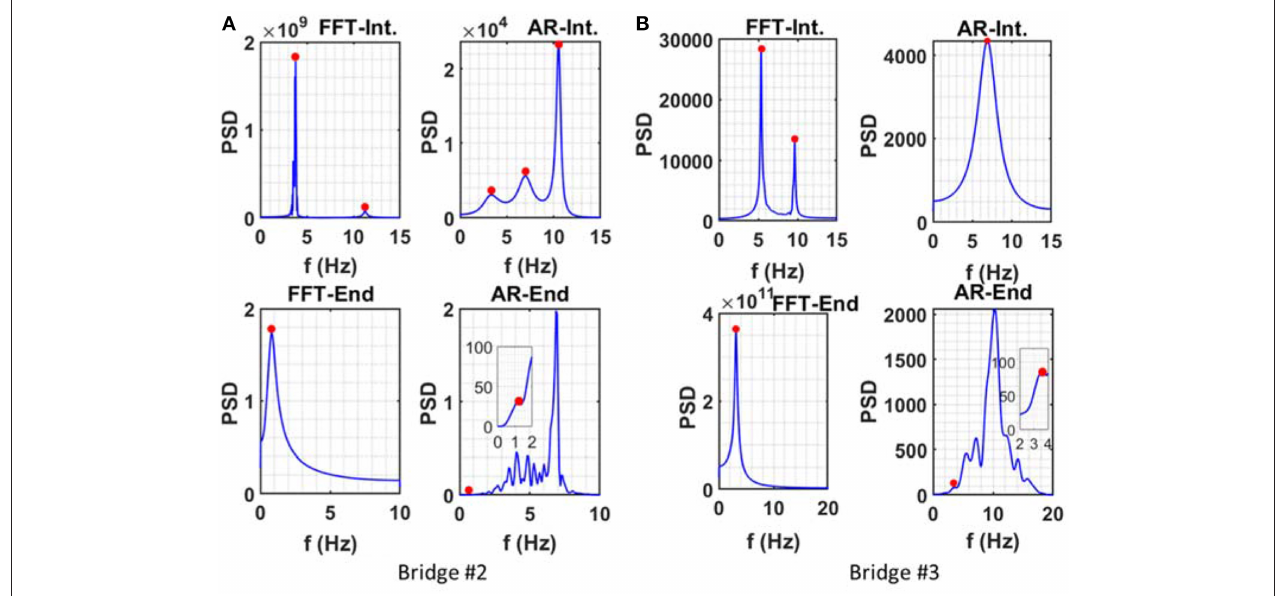
FIGURE 7 | Sample of PSD spectrum before and after the seismic tests from: (A) transverse white noise for the steel girder bridge, and (B) longitudinal white noise for concrete bridge.